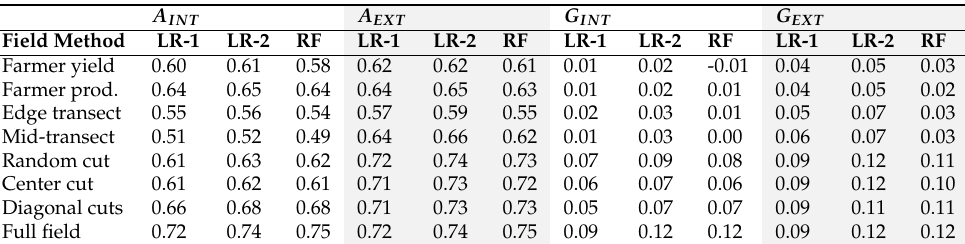
Table 4. Internal ( A INT ) and external accuracy ( A EXT ) and gain ( G INT and G EXT ) for models predict- ing maize yield from reflectance based on data from different field methods. Internal measures are based on standard cross-validation using data from a possibly inaccurate sample, whereas external measures compare predictions with true yield values. Accuracy is 1 for a perfect model and lower for other models. Gain is zero if the model is not better than the NULL model of observed mean yield. For each field method, we show the highest score for any of the 45 single-variable linear regression models (LR-1) or for the 990 two-variable linear regression models (LR-2) and for the Random Forest (RF) model.